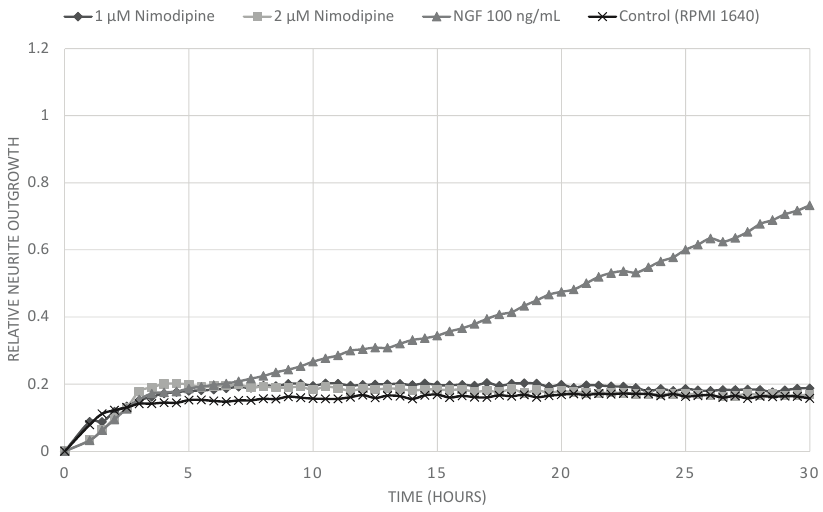
Figure 5. Measurement of realtive neurite outgrowth of PC12 cells using the xCELLigence real-time cell analyzer. Cells were treated with with 100 ng/mL NGF, 1 µM or 2 µM nimodipine. Untreated cells or cells treated with 1 µM or 2 µM nimodipine showed no neurite outgrowth, while treatment with 100 ng/mL NGF led to neurite outgrowth.